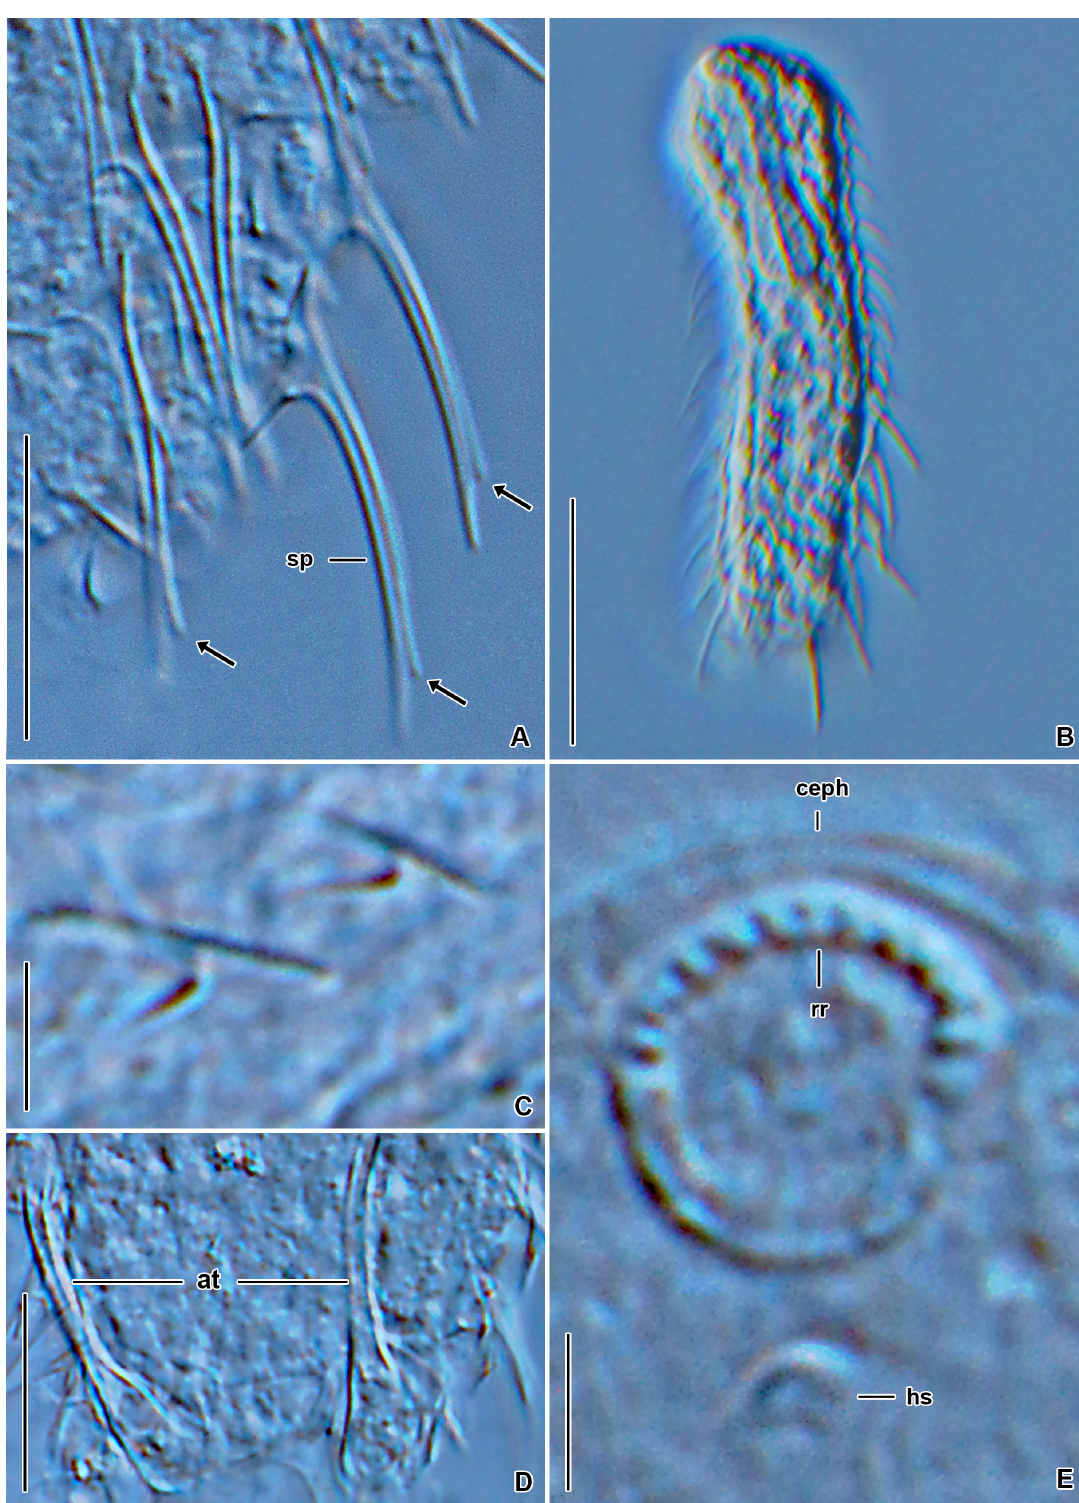
Fig. 38. Chaetonotus ( Hystricochaetonotus ) arcanus sp. nov., holotype (CU-FNS-29-09-20/HO), differential interference contrast. A . Dorsal trunk scales and spines. Arrows mark lateral denticles. B . Body overview. C . Head scales. D . Adhesive tubes curved underneath trunk. E . Mouth and boomerang- like hypostomial plate. Scale bars: A, D = 10 µm; B = 30 µm; C, E = 2